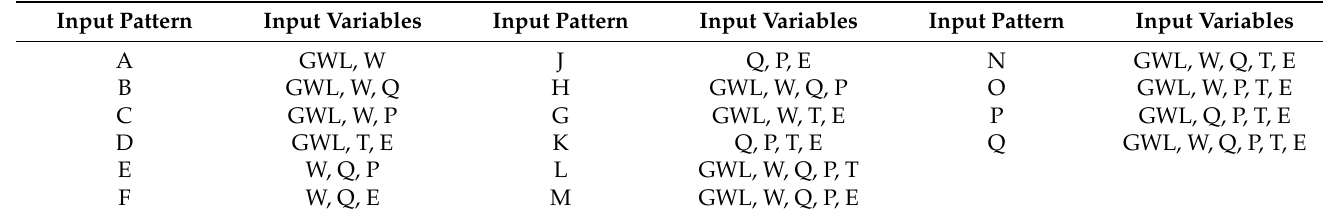
Table 4. Input patterns for the prediction of GWL for observation well